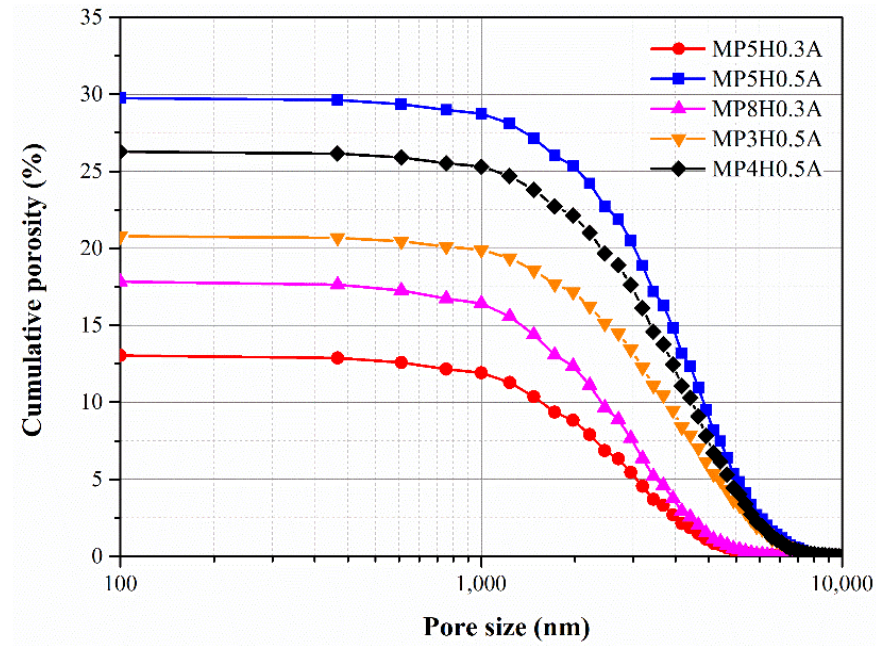
Figure 13. Comparison of cumulative porosity in different MAPC pastes.